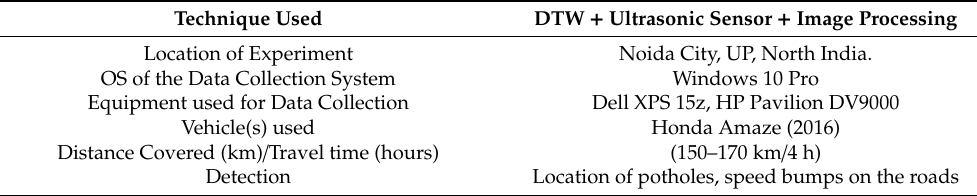
Table 2. Software and hardware specifications used in the experimental setup Technique Used